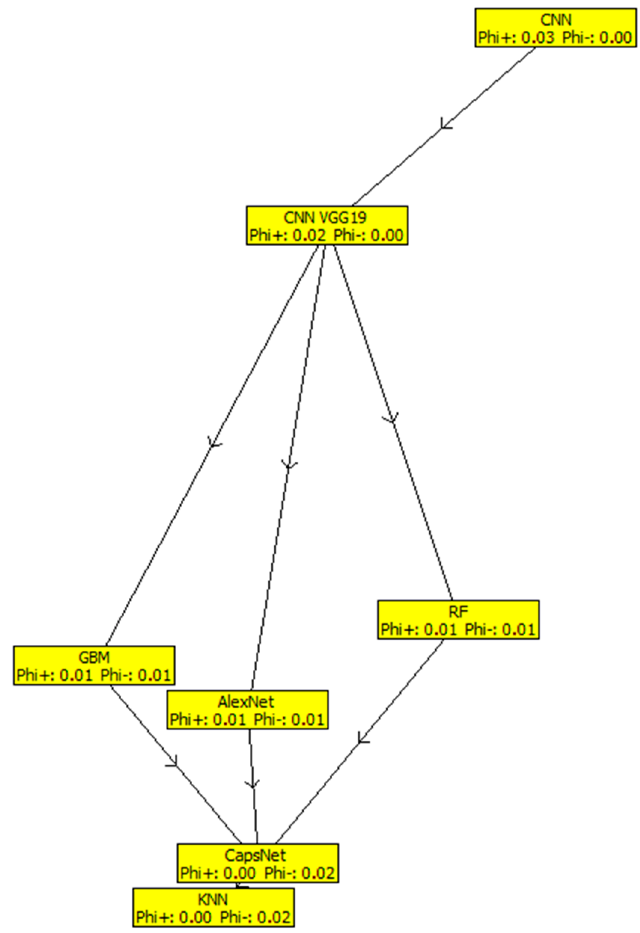
Figure 2. Fuzzy-based PROMETHEE network